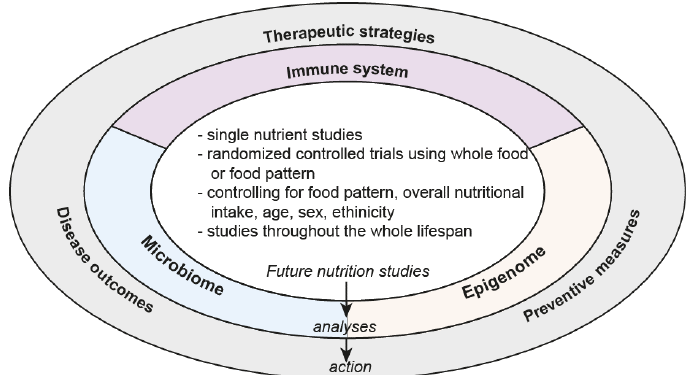
Figure 2. Future direction of nutritional research.